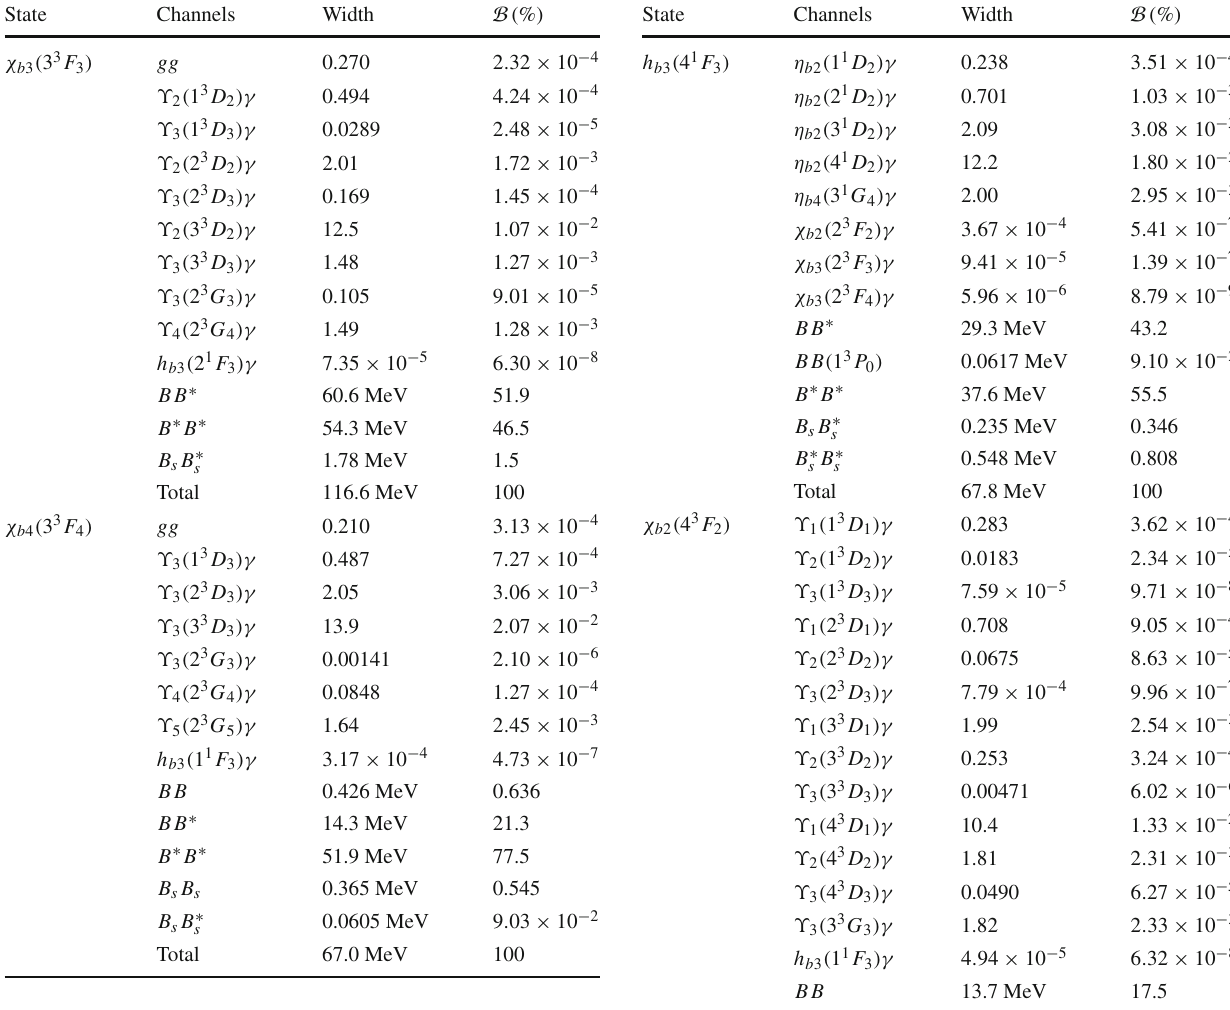
Table 36 Partial widths and branching ratios of OZI-allowed strong decay, annihilation decay, and radiative transition and the total widths for 4 1 F 3 and 4 3 F 2 bottomonium states. The width results are in